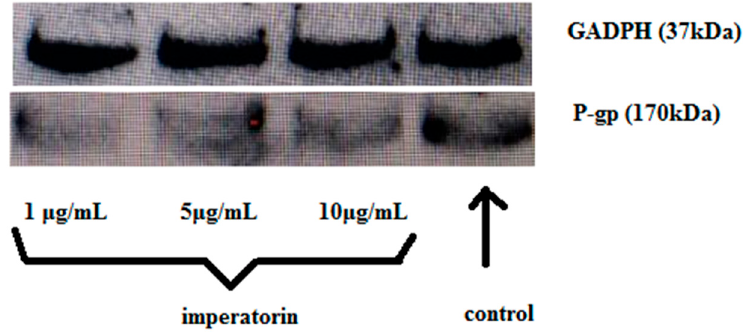
Figure 5. Effect of imperatorin on P-gp expression level.